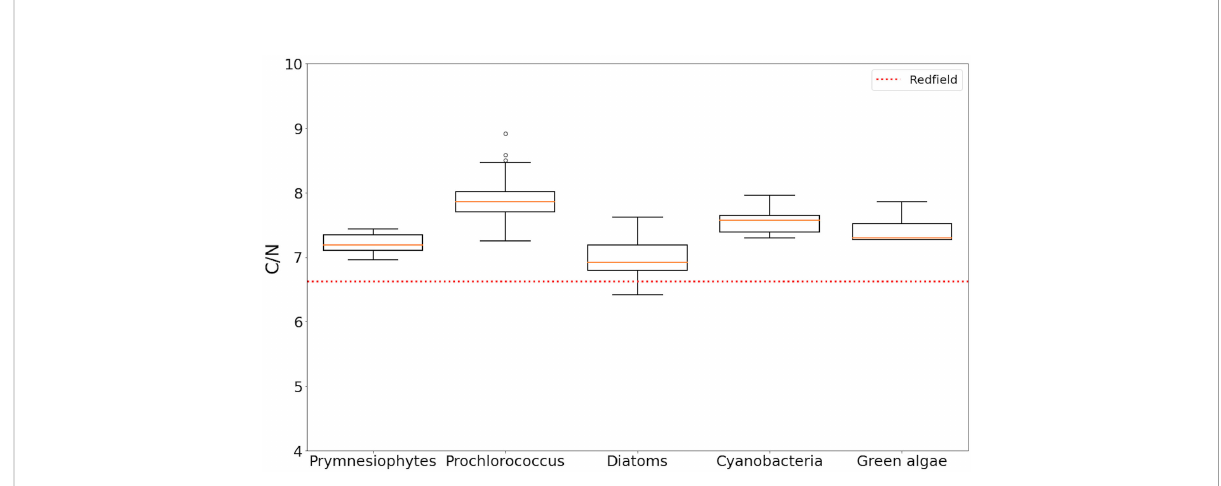
FIGURE 4 Boxplot of C:N ratios speci fi c to the fi ve phytoplankton taxa identi fi ed through HPLC analysis. Red fi eld ratio is highlighted by the dotted red line. See Table 3 for the mean and range of taxon-speci fi c ratio.